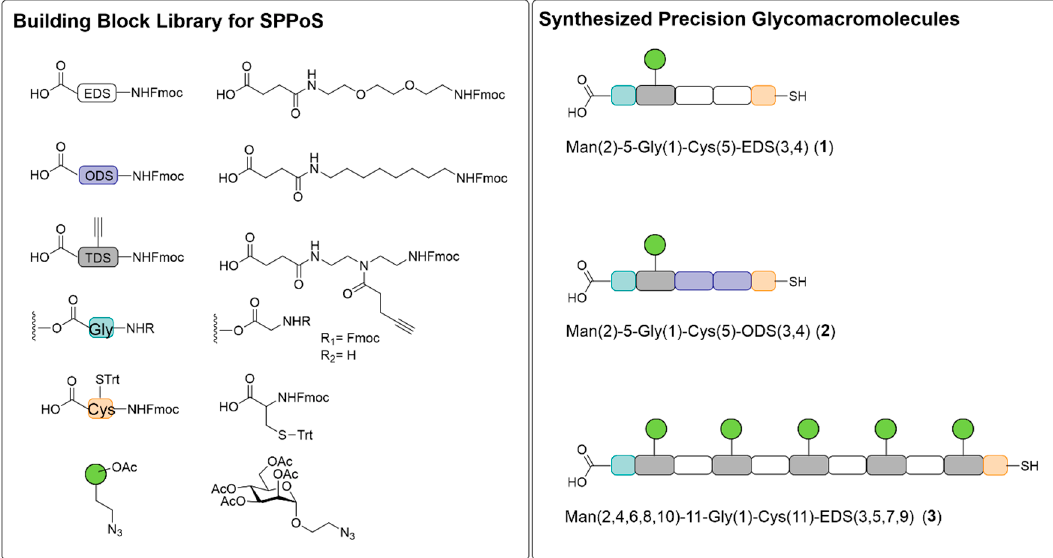
Figure 1. Schematic presentation of the building block library used for SPPoS and of the three synthesized glycomacromolecular structures 1 – 3 .